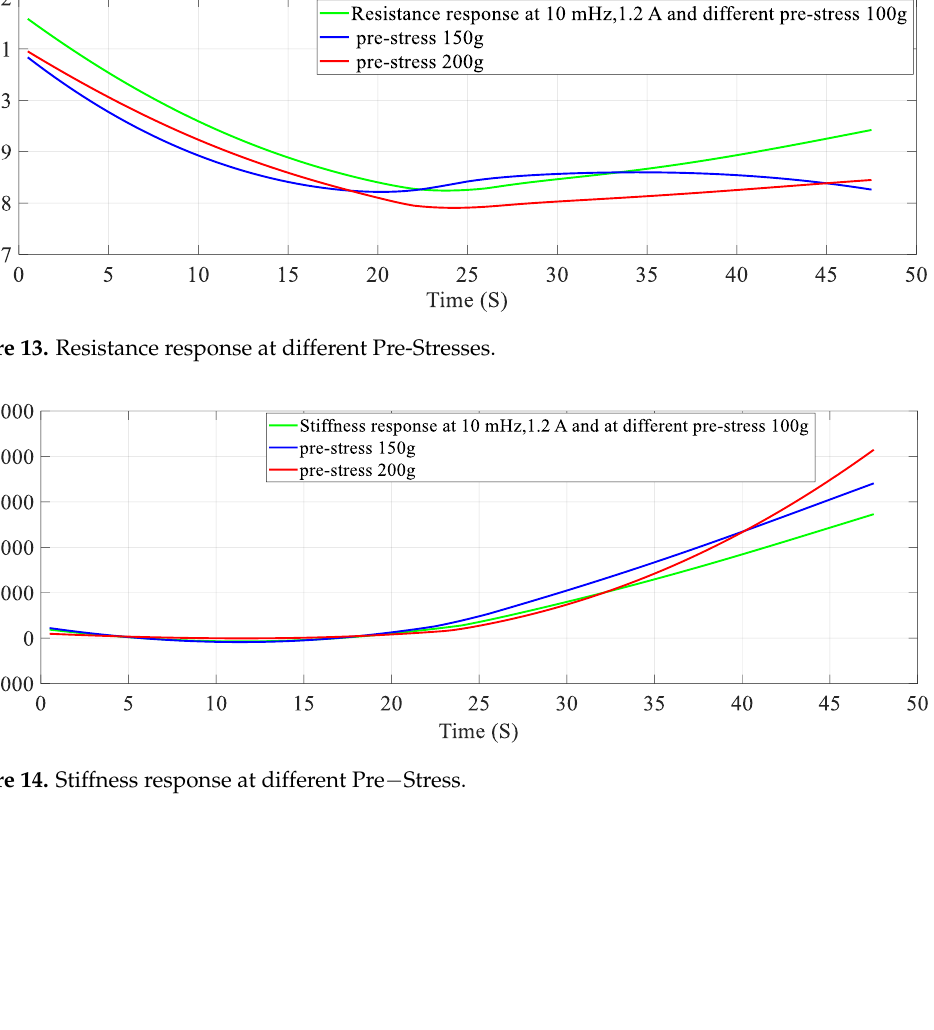
Figure 15. Stiffness − R esistance characteristics at different Pre −S tresses. 5.4. Effect of Duty Cycle on Stiffness — Resistance characteristics Similarly, for different duty cycles (40%, 50%, and 60%) at 1.5 A and 20 mHz, the resistance response, stiffness response and stiffness — Resistance characteristics of the SMA spring actuator are obtained and presented in Figures 16 – 18 respectively. Resistance values are smaller in comparison to the effect of current, frequency and pre-stress. The change in resistance is higher for higher duty cycles and lower for lower-duty cycles. Change in stiffness is also higher for a higher duty cycle and lower for a lower duty cycle; stiffness is higher in comparison with a lower duty cycle due to the availability of minimal time to completely heat the SMA spring. Figure 16 presents the resistance variation due